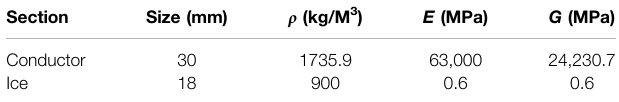
TABLE 1 | Parameters of the iced eight-bundle conductor.